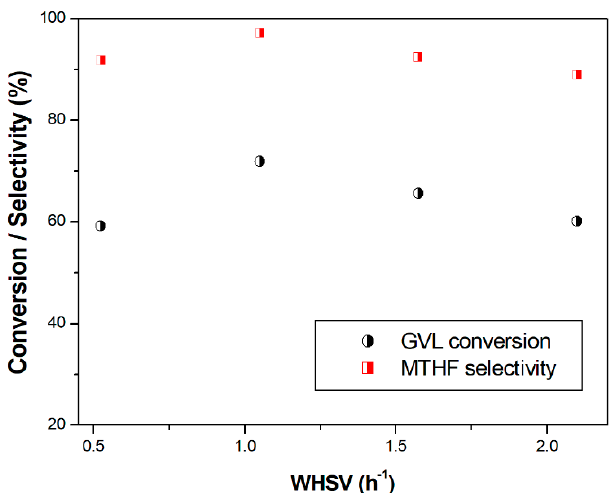
Figure 10. Influence of WHSV on the catalytic performance of 5 wt% Cu/SiO 2 . Reaction conditions at various WHSV: 10 wt% GVL of reaction feed, 0.4 g of 5 wt% Cu/SiO 2 catalyst, 260 °C reaction temperature.